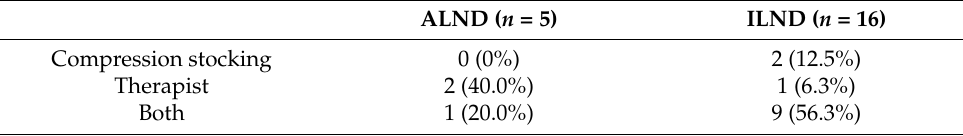
Table 5. Use of supportive care for patients with